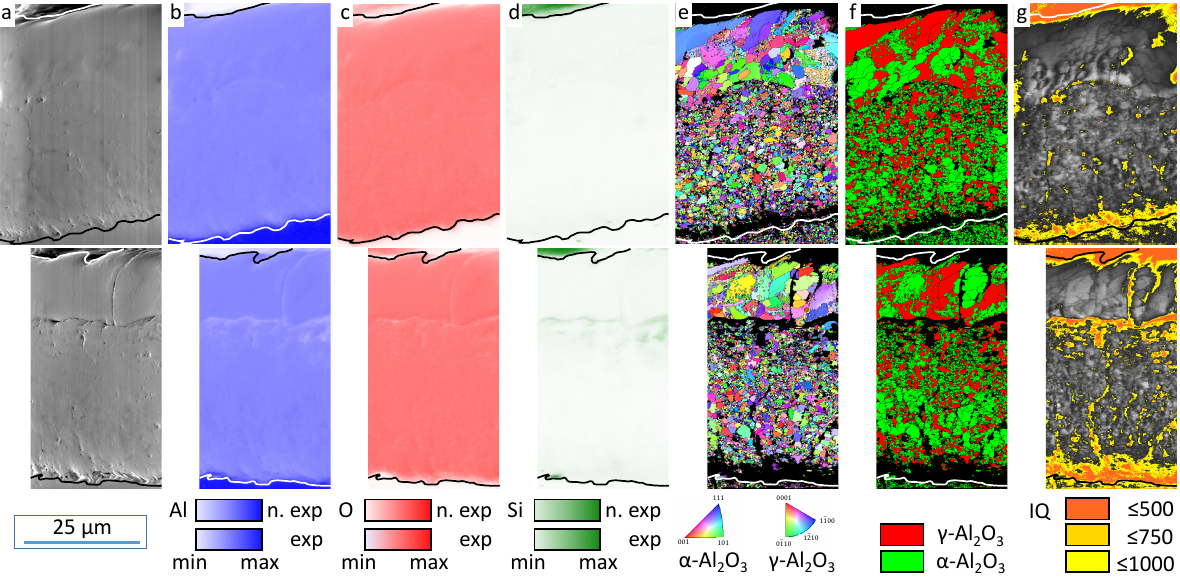
Figure 6. SEM ( a ) image as well as EDX ( b – d ) and EBSD ( e – g ) maps for the cross-section of a sample exposed to electrolyte I at unaffected (top) and affected (bottom) surface regions (Pos. 1 and 2 in Figure